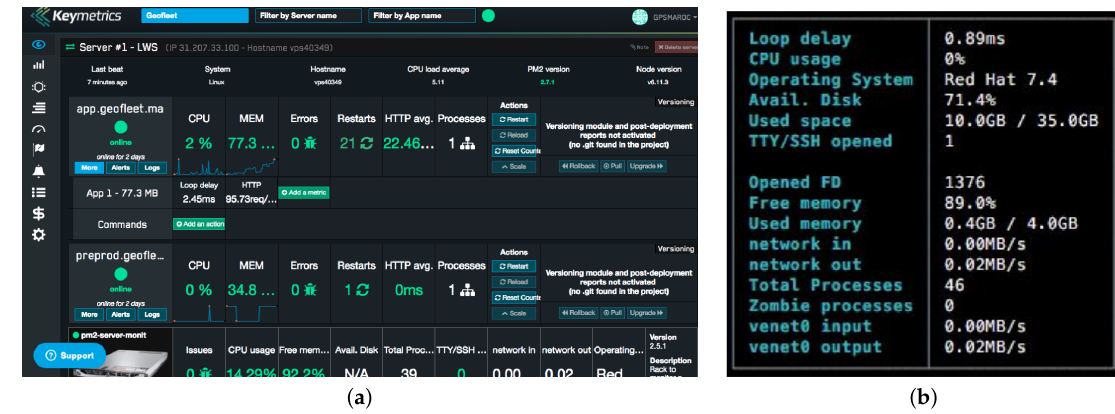
Figure 15. PM2 real-time framework statistics: ( a ) real-time monitoring; ( b ) framework server